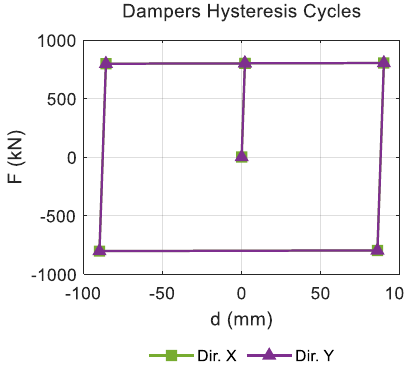
Figure 17. Selected Friction Dampers (FD) Hysteresis Cycle.